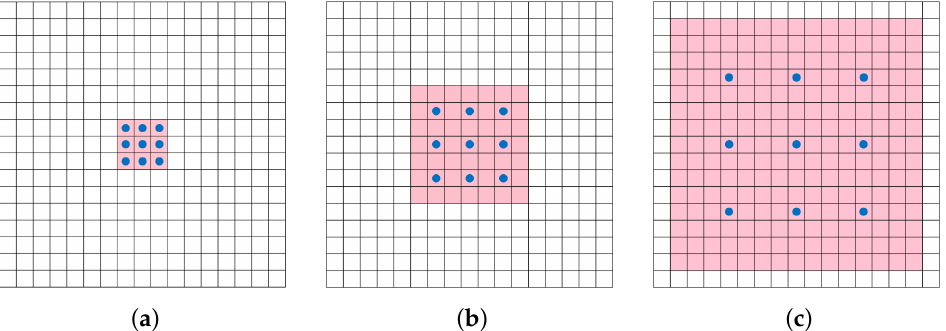
Figure 6. The receptive fields of 3 × 3 convolution kernel corresponding to different dilated rates. ( a ) has a receptive field of 3 × 3 when dilated rate is 1. ( b ) has a receptive field of 7 × 7 when dilated rate is 2. ( c ) has a receptive field of 15 × 15 when dilated rate is 3.